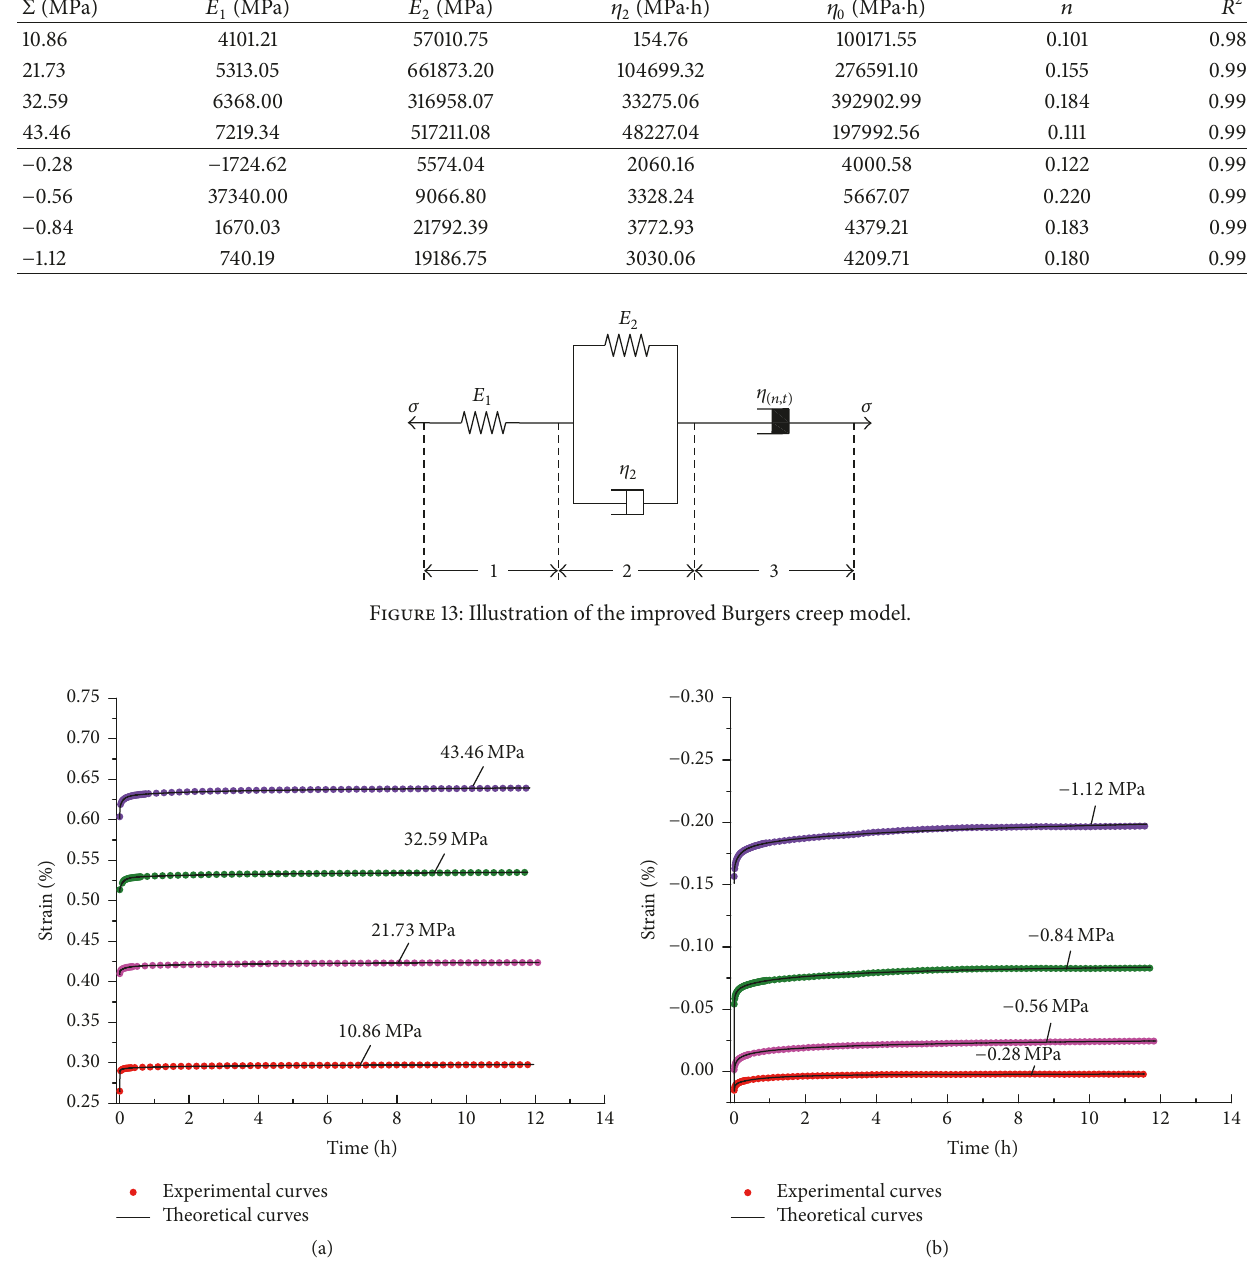
Figure 14: Comparison between improved Burgers creep model curves with the experimental result (a) under compressive stress and (b) under tensile